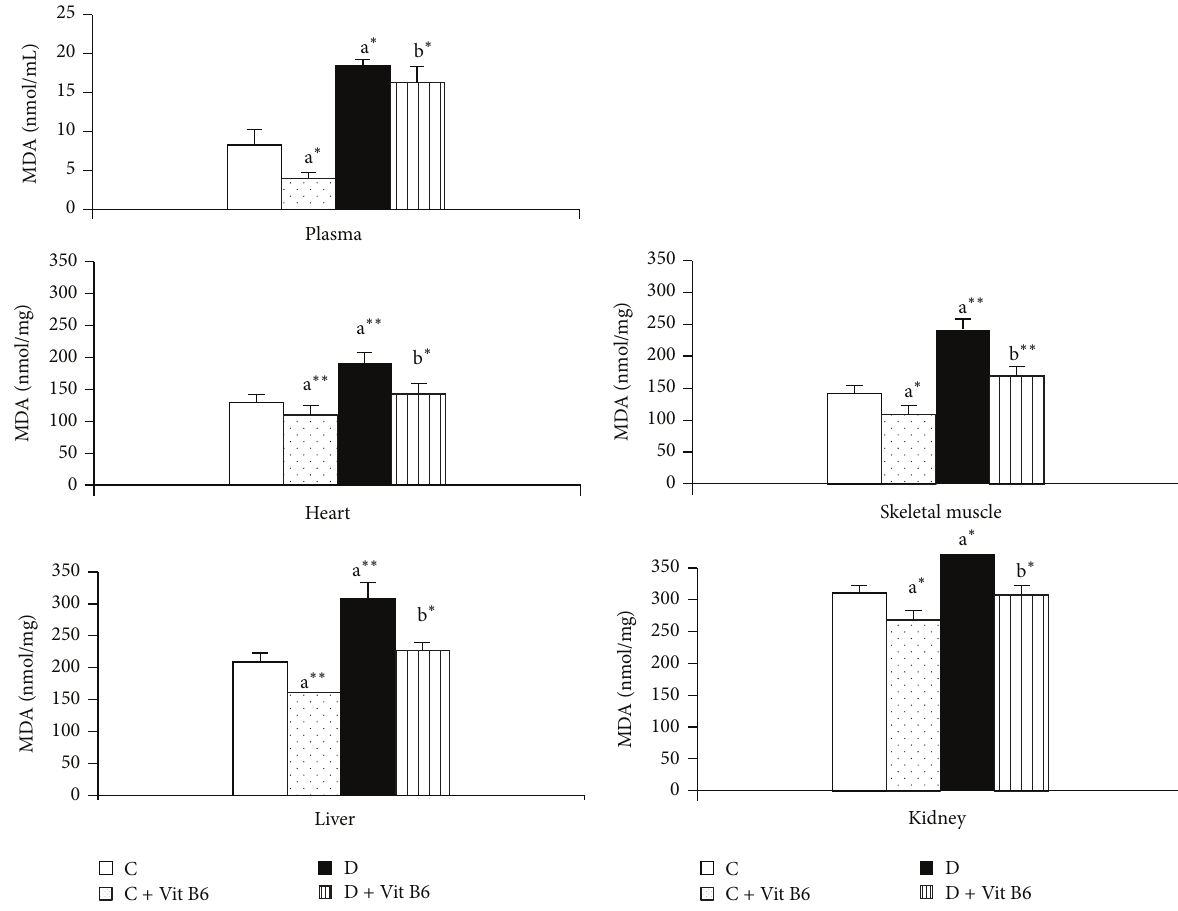
Figure 1: Malondialdehyde (MDA) levels in plasma (nmol/mL) and tissues (nmol/mg tissue) of the control and experimental rats. Values are expressed as mean ± SEM (standard error of mean) for eight rats in each group. Statistical comparison: 𝑎 compared with the C group, 𝑏 compared with the D group. Statistical significance, ∗ 𝑃 < 0.05 and ∗∗ 𝑃 < 0.01 . For abbreviations of study groups; see Table